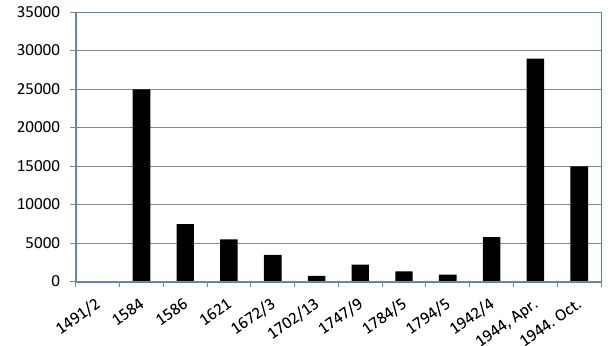
Figure 7. Flood events caused during warfare in the SW Nether- lands, 1491–1944. The intensity and damage are indicated in